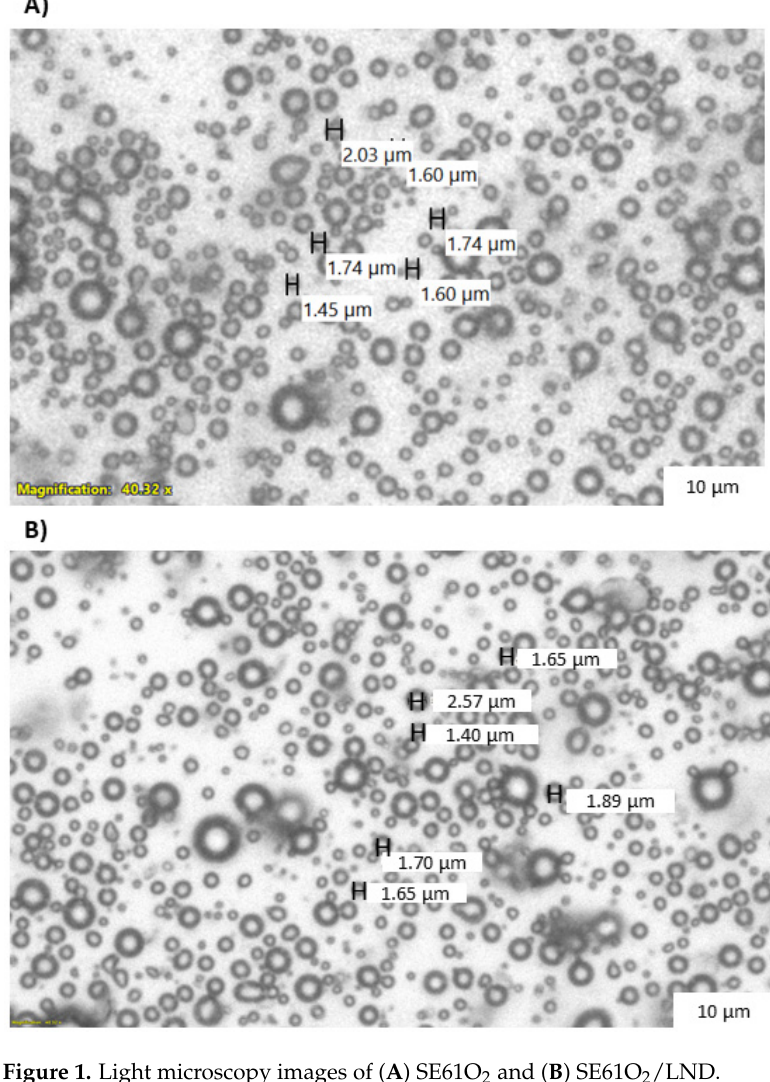
Figure 1. Light microscopy images of ( A ) SE61O 2 and ( B ) SE61O 2